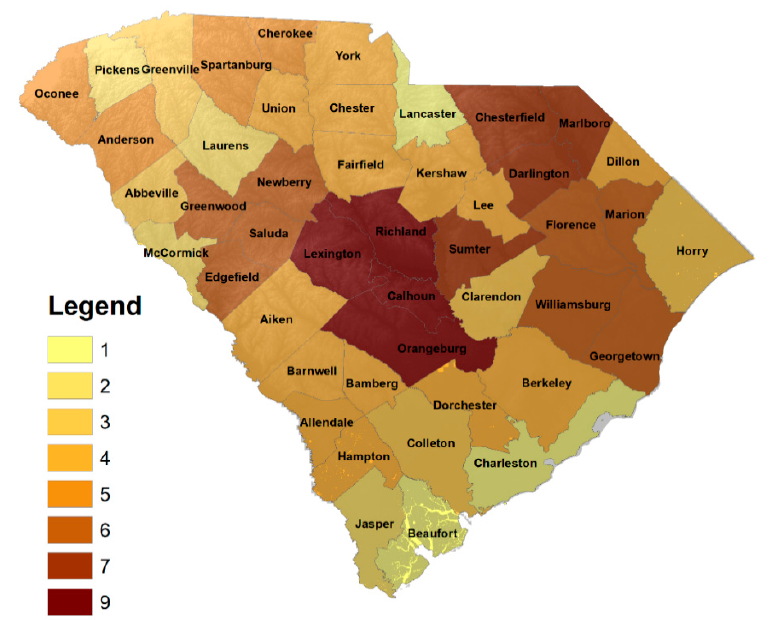
Figure 2. Distribution of respondents from each county in SC, count indicated by color.